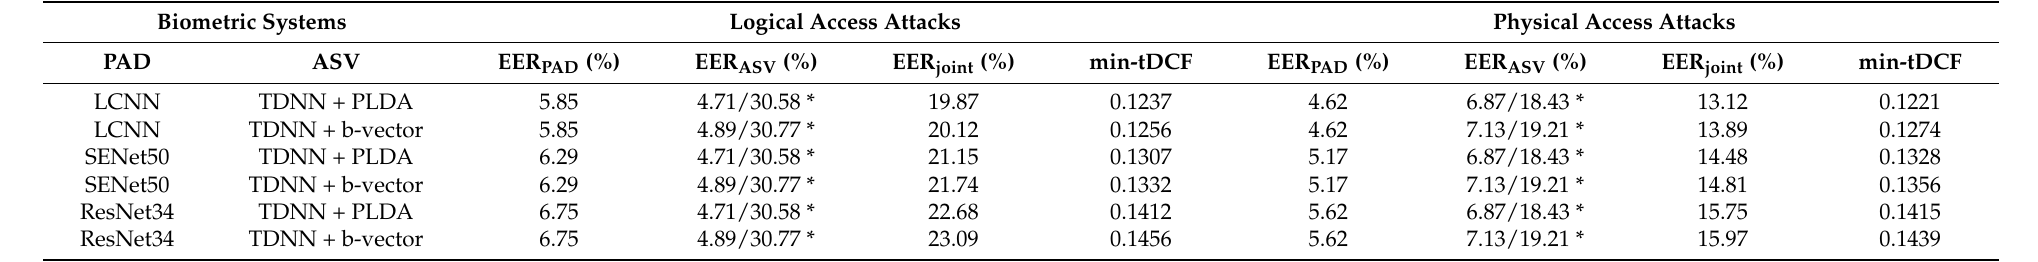
Table 1. Results of different complete voice biometric systems evaluated on the ASVspoof 2019 logical access (LA) and physical access (PA) test datasets in terms